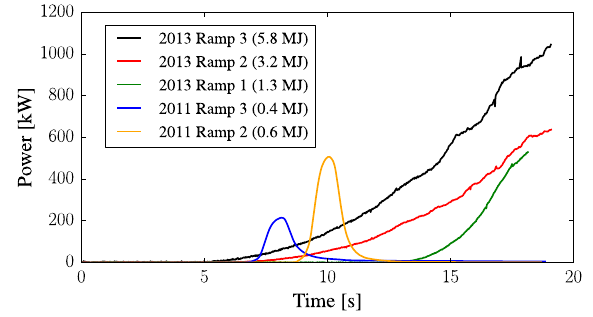
FIG. 16. Measured peak power losses by the beam in the collimation system versus time during the collimation quench tests in 2011 and 2013. In 2013 tests, beams were dumped after achieving the targeted loss rate.